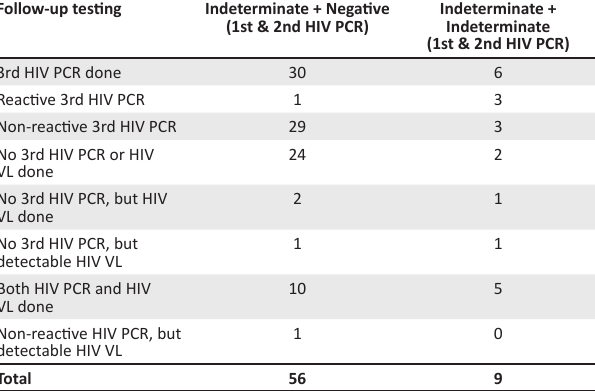
VL, viral load; PCR, polymerase chain